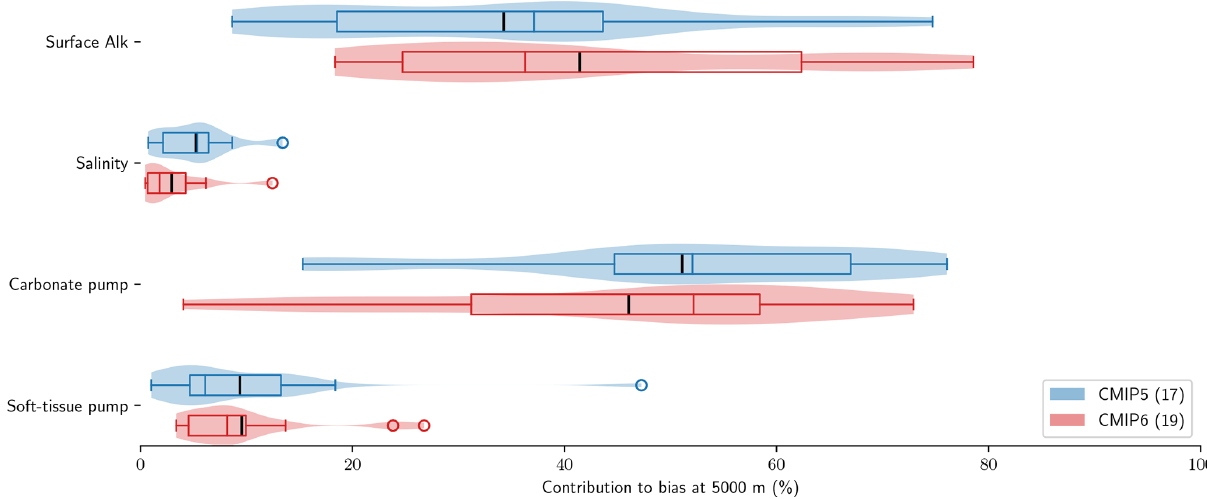
Figure 7. Relative contributions to sAlk biases between ESMs and GLODAPv2 observations at 5000m. Violin plots of the CMIP5 and CMIP6 ensembles with the ensemble mean (black tick) and quartiles (boxes) given for each